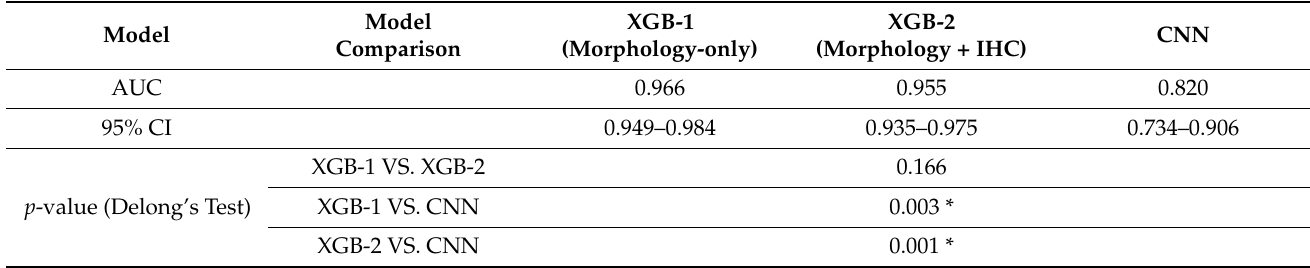
Table 4. Comparison of model performance based on the case-level prediction.